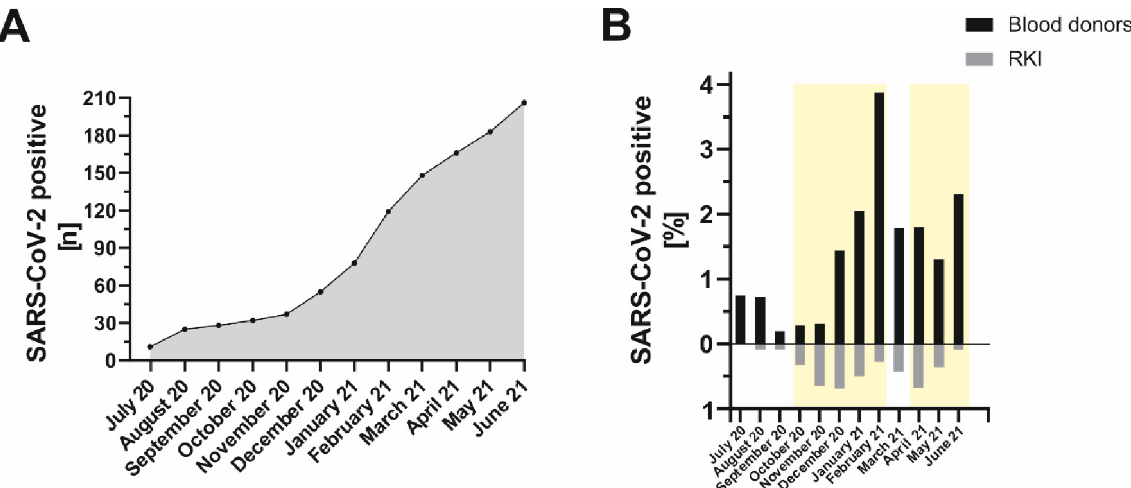
Fig 2. Monthly anti-SARS-CoV-2 antibody detection in the period between July 2020 and June 2021 in blood donors residing in the three German federal states of North Rhine-Westphalia, Lower Saxony and Hesse. A: Cumulative incidence of anti-SARS-CoV-2 IgG seropositive blood donors by month. B: Comparison of percentage anti-SARS-CoV-2 positivity rate among blood donors (seroprevalence, black bars) with officially reported data from the Robert Koch Institute (RKI) [16] (PCR detection, grey bars). The light-yellow areas symbolize the second and third corona wave in